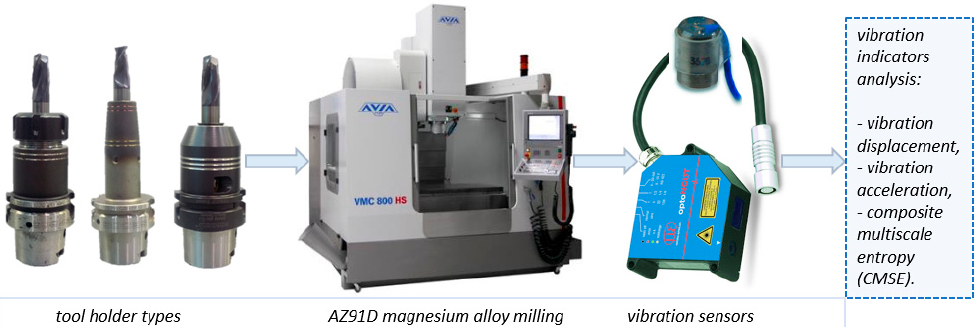
Figure 2. Schematic diagram of the test set-up.